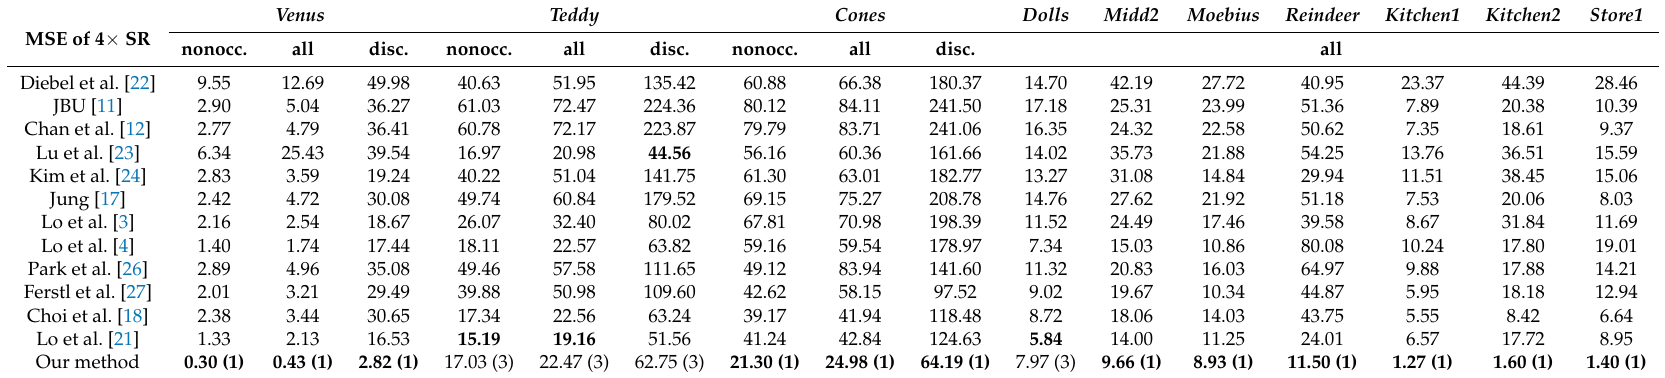
Table 2. Comparisons of MSE with upsampling factors of 4. For each image, the ranking of our approach is shown in the parenthesis, and the best performance is shown in